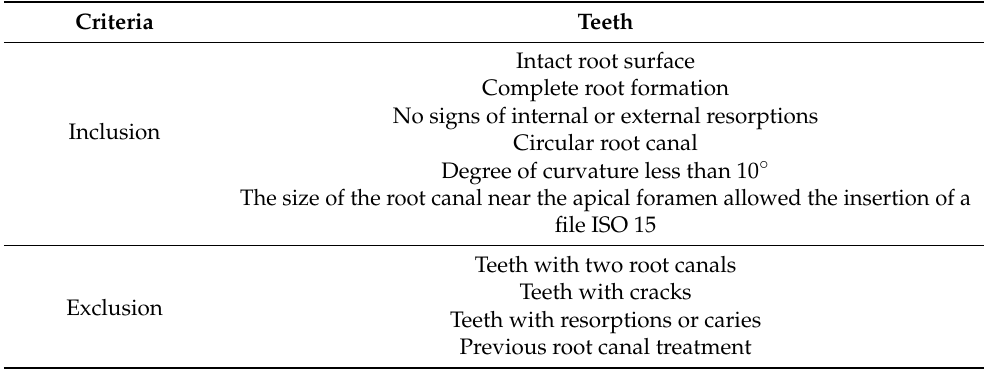
Table 1. Inclusion and exclusion criteria for selected